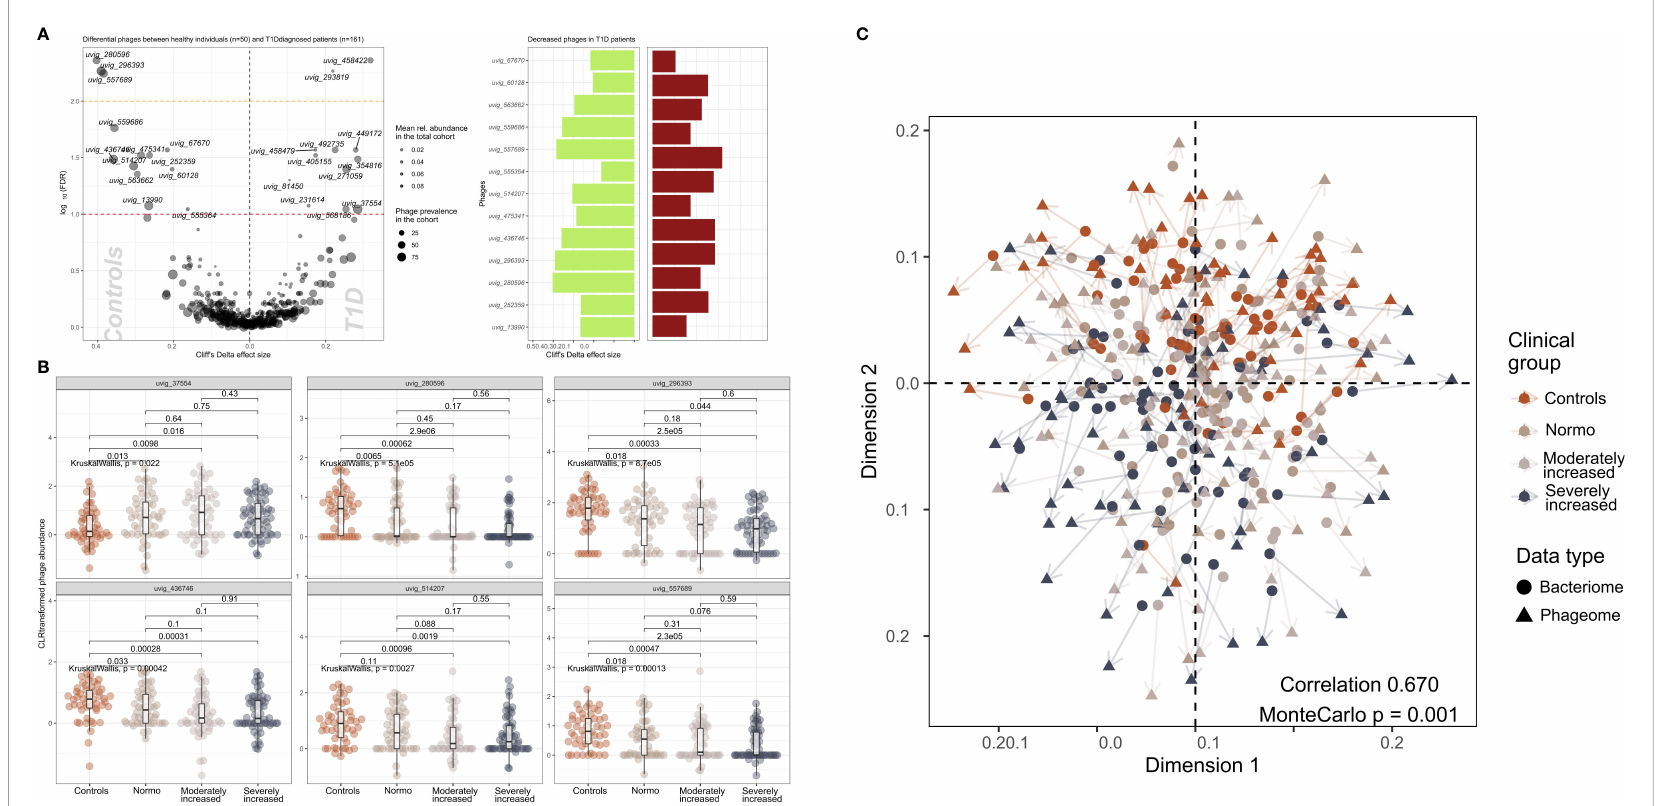
FIGURE 3 Contrasted relative abundance of bacteriophages in T1D and healthy control individuals. (A) In the left panel, a volcano plot compares the relative phage abundances between T1D and healthy individuals. The X-axis represents Cliff ’ s Delta effect size while the Y-axis represents the association threshold for the comparison, (negative log) FDR-adjusted p-value. Signi fi cantly contrasted phages (above the red dotted line) are annotated. Dot size is relative to the global prevalence of phage in the present study sample, while their transparency is relative to their mean abundance in the cohort. In the right panel, signi fi cantly contrasted phages are shown as bar plots corresponding to Cliff ’ s Delta effect sizes. Phages with signi fi cantly lower abundance in T1D are indicated as green bars while red bars represent phages with signi fi cantly higher abundance in T1D. (B) Distribution of abundance of selected phages when comparing healthy controls with the three groups of T1D strati fi ed by albuminuria. For each phage, the CLR-transformed abundance distribution is represented in differently colored dots and boxplots showing the global group distribution. Multi-group comparison computed with Kruskal-Wallis test is included in each plot, as well as the pairwise comparisons between all study groups, performed with Wilcoxon test. (C) Comparison between the global composition of the phageome and the bacteriome, performed with Procrustes test. Principle coordinates analysis (PCoA) shows the disposition of individuals in the corresponding scores plot, for both bacteriome (circles) and phageome (triangles) based distance matrix. An arrow has been drawn connecting the same individuals. Individuals have been colored depending on their clinical group. Correlation and signi fi cance are indicated in the bottom right corner of the